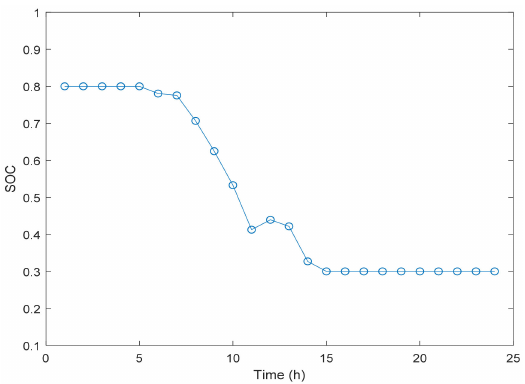
Figure 12. Aggregated SOC of EVs in Case 1.